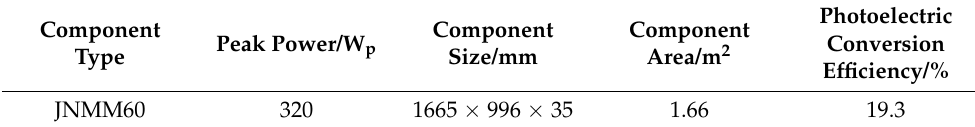
Table 1. Parameters of JNMM60 photovoltaic